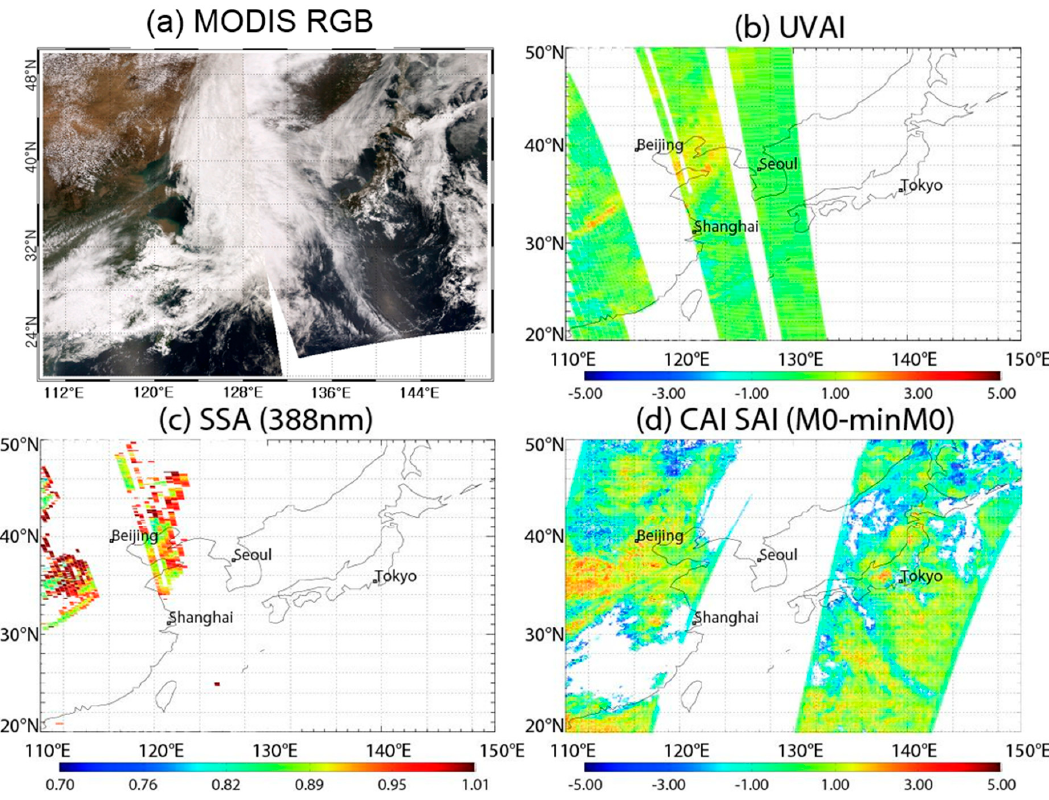
Figure 9. OMI UVAI, SSA, and calculated CAI-SAI for UTC 04:40 on April 25 2012 over the Korean Peninsula. ( a ) MODIS RGB has an 8-min time difference compared with OMI; ( b ) A single path of OMI lv.2 UVAI (354 and 388 nm) data is projected. A sun-glint area near the south coast of China was removed because this area has a brighter surface than other ocean surface areas; ( c ) OMI lv.2 SSA 388 nm ( d ) SAI calculated from TANSO-CAI with a 30-min time difference compared with OMI.